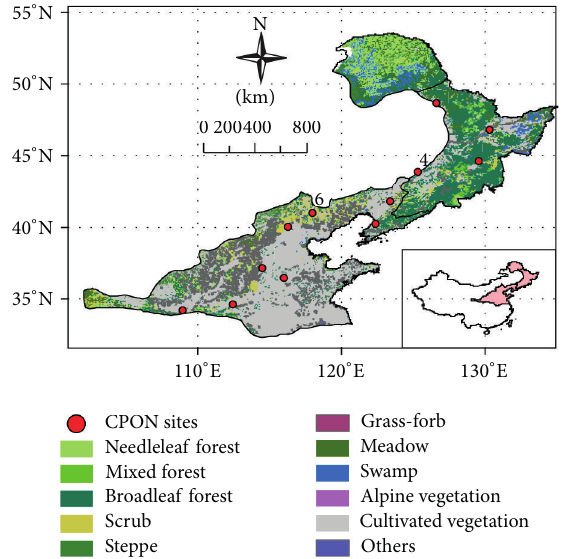
Figure 1: Distribution of vegetation types in China’s temperate monsoon area and the twelve sites from Chinese Phenological Observation network (CPON) in this study.